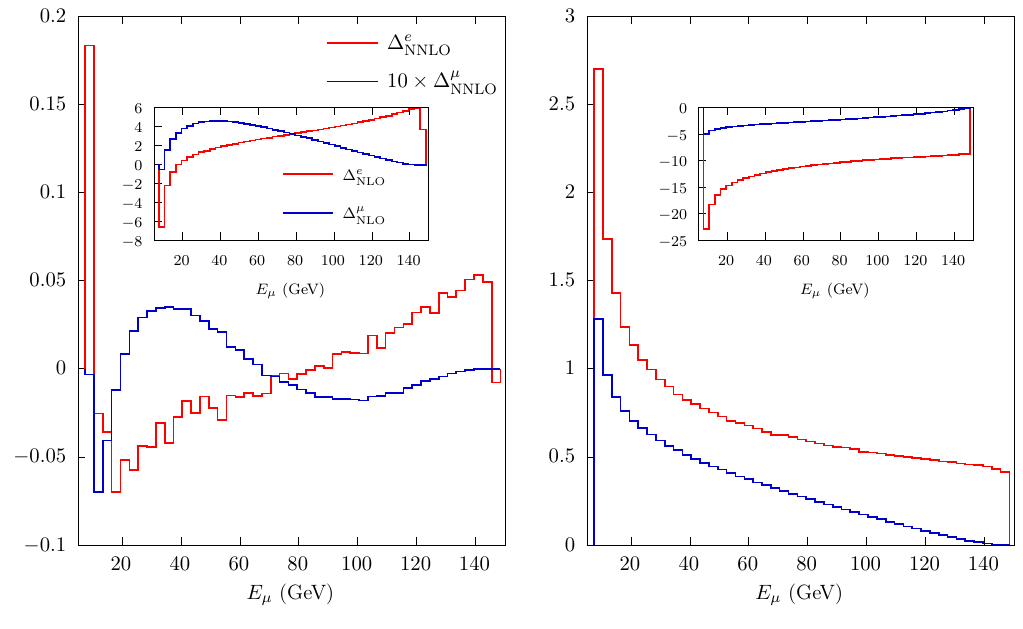
Figure 6 . The same as (cid:12)gure 3 for the muon energy E (cid:22)